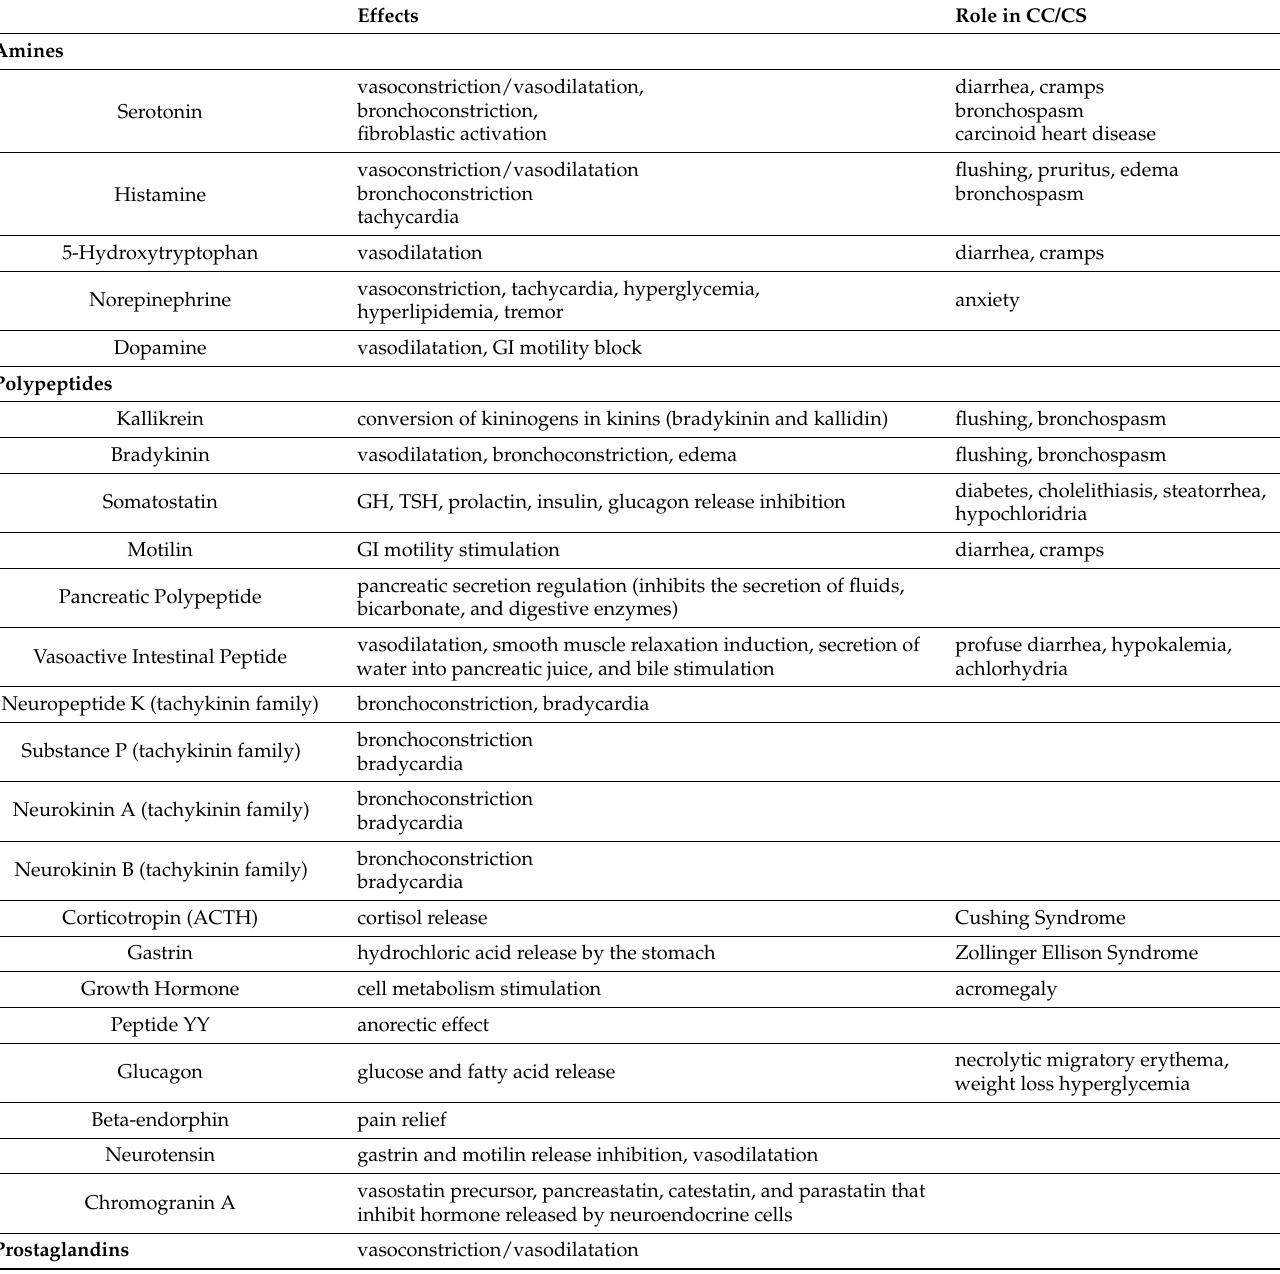
Table 2. Molecules implicated in